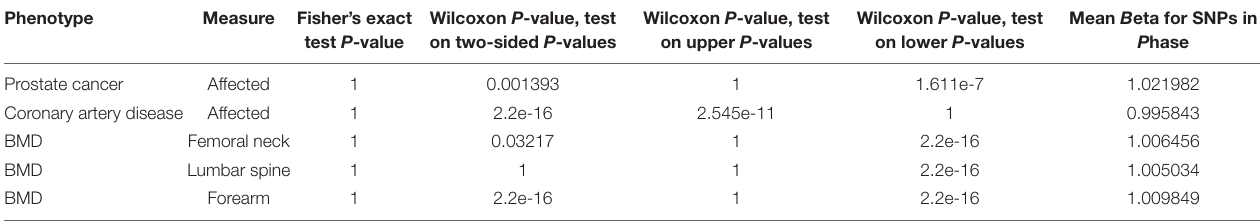
TABLE 1 | Disease phenotypes, measurements and corresponding test